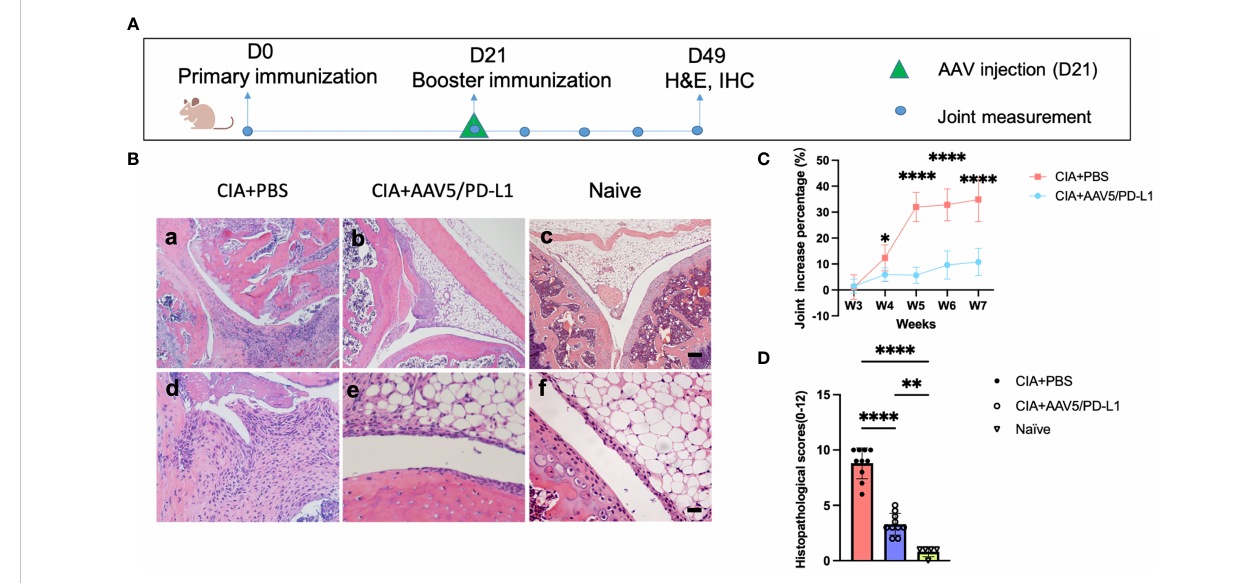
FIGURE 9 Improved arthritis in the synovium of CIA mice treated with AAV5/PD-L1 vectors as a therapeutic regimen. (A) , Schematic diagram of animal experiment. AAV5/PD-L1 at a dose of 1x10 10 particles was intra-articularly injected on day 21 into the knees of CIA mice. Knee joint size and joint histopathological alteration were monitored. (B) , Knee joint histology analysis with H&E staining. Representative images are shown (a-c, bar=200 m m; d-f, bar=20 m m). (C) , The change in knee joint swelling. Data is shown as means ± SEM. *P < 0.05, ****, p < 0.001. (D) , Knee joint histological scores. Mean values are shown with standard derivation (n=10). Data was analyzed using one-way ANOVA followed by Bonferroni multiple comparison test for group comparisons. **P < 0.01, ****, p <